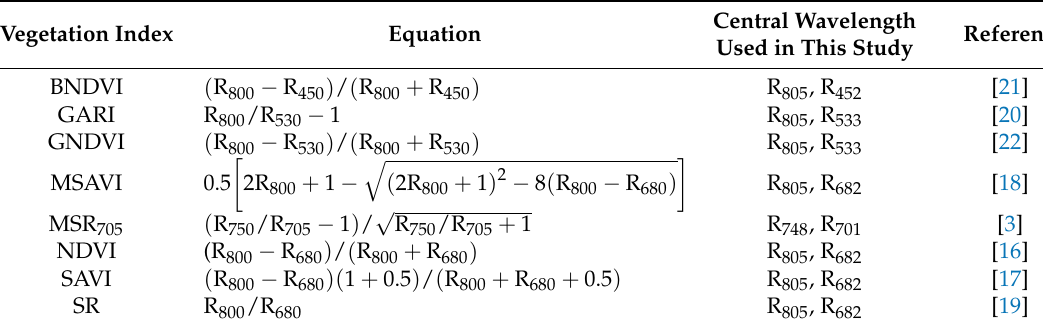
Table 2. Narrow-band vegetation indices used in the